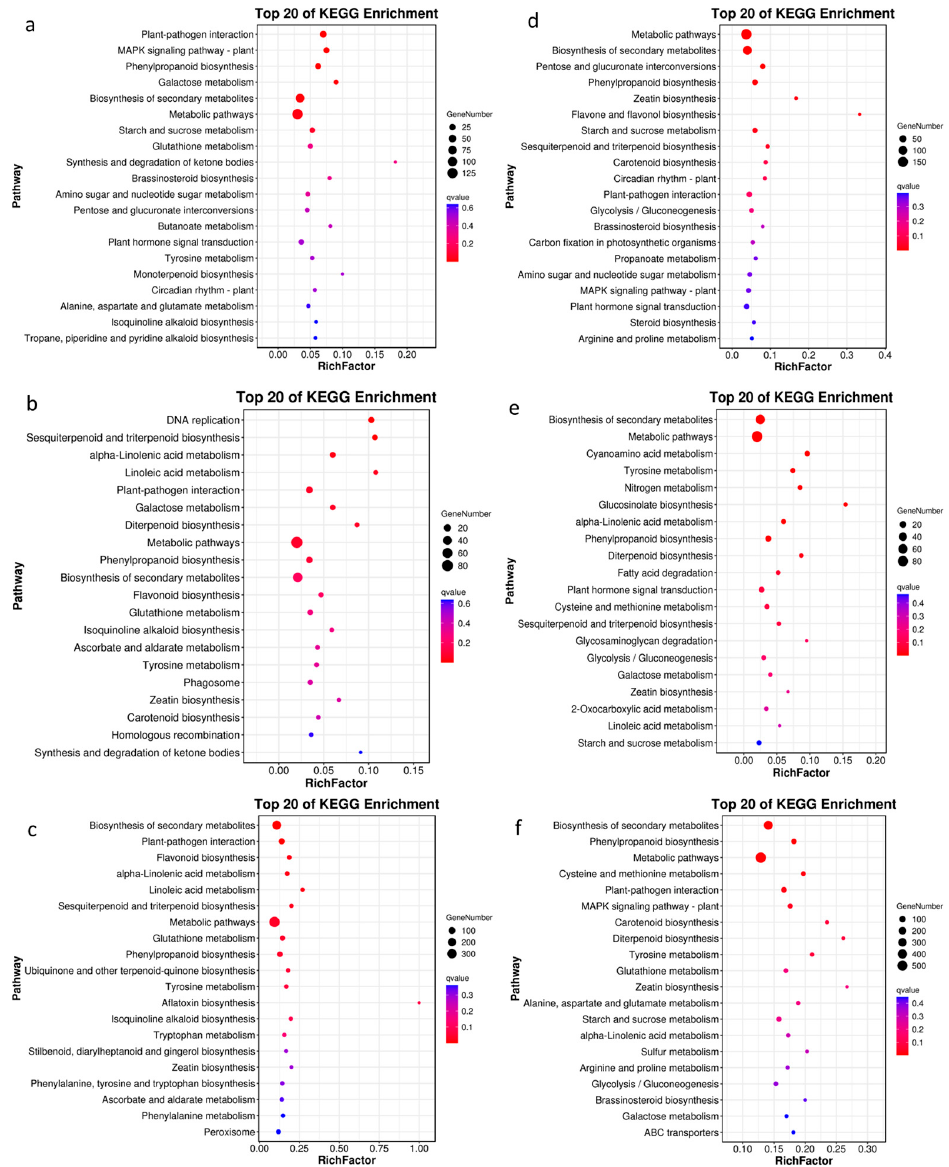
Figure 3. The top 20 KEGG pathways for DEGs in three combinations. ( a ) The top 20 KEGG pathways for DEGs in M-CKL vs. M-TL. ( b ) The top 20 KEGG pathways for DEGs in Z-CKL vs. Z-TL. ( c ) The top 20 KEGG pathways for DEGs in M-TL vs. Z-TL. ( d ) The top 20 KEGG pathways for DEGs in M-CKR vs. M-TR. ( e ) The top 20 KEGG pathways for DEGs in Z-CKR vs. Z-TR. ( f ) The top 20 KEGG pathways for DEGs in M-TR vs.